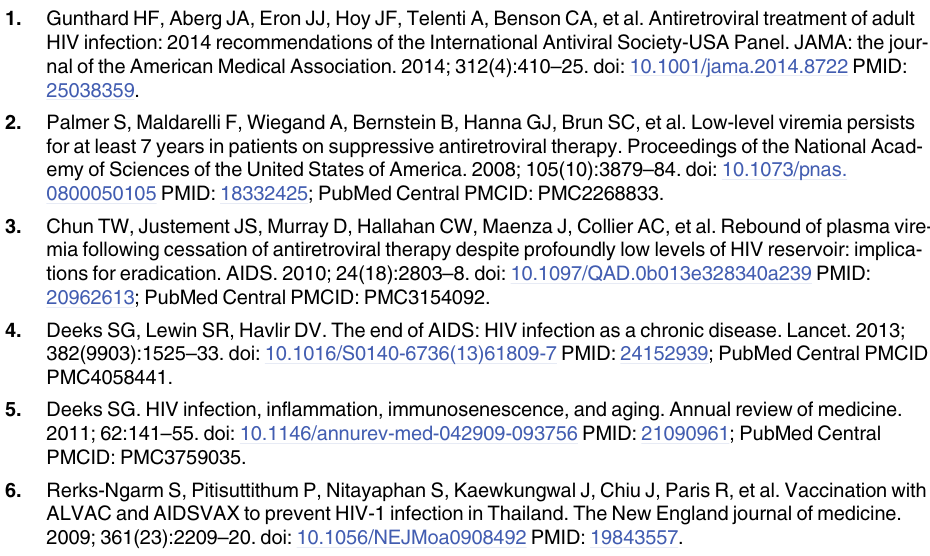
S2 Fig. Representative Image of Inflammatory Score 0. This is a representative image of a skin biopsy corresponding to an inflammatory score of 0 (no inflammation present). S3 Fig. Representative Image of Inflammatory Score 1. This is a representative image of a skin biopsy corresponding to an inflammatory score of 1 (mild inflammation present). S4 Fig. Representative Image of Inflammatory Score 2. This is a representative image of a skin biopsy corresponding to an inflammatory score of 2 (moderate inflammation present). S5 Fig. Representative Image of Inflammatory Score 3. This is a representative image of a skin biopsy corresponding to an inflammatory score of 3 (severe inflammation